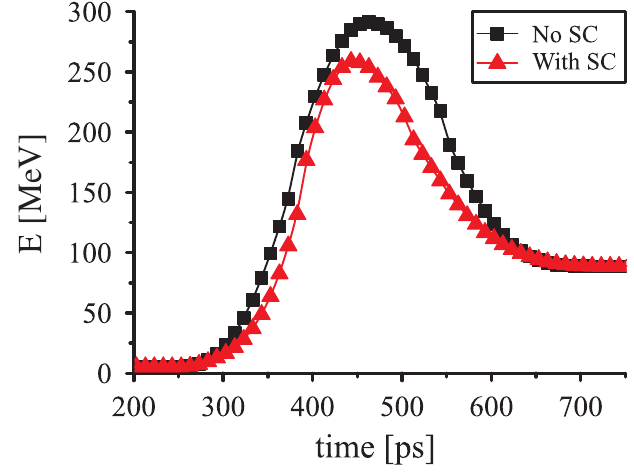
FIG. 13. (Color) Average energy ( E ) of a 10 pC injected electron bunch during compression with and without taking space charge into account.